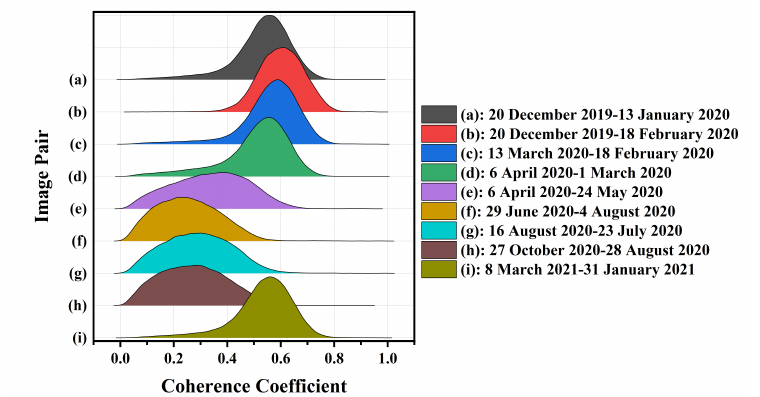
Figure 8. Statistical distribution of coherence coefficient. Subfigures ( a – i ) are the Statistical distribu- tion of coherence coefficient corresponding to the image pairs in Table